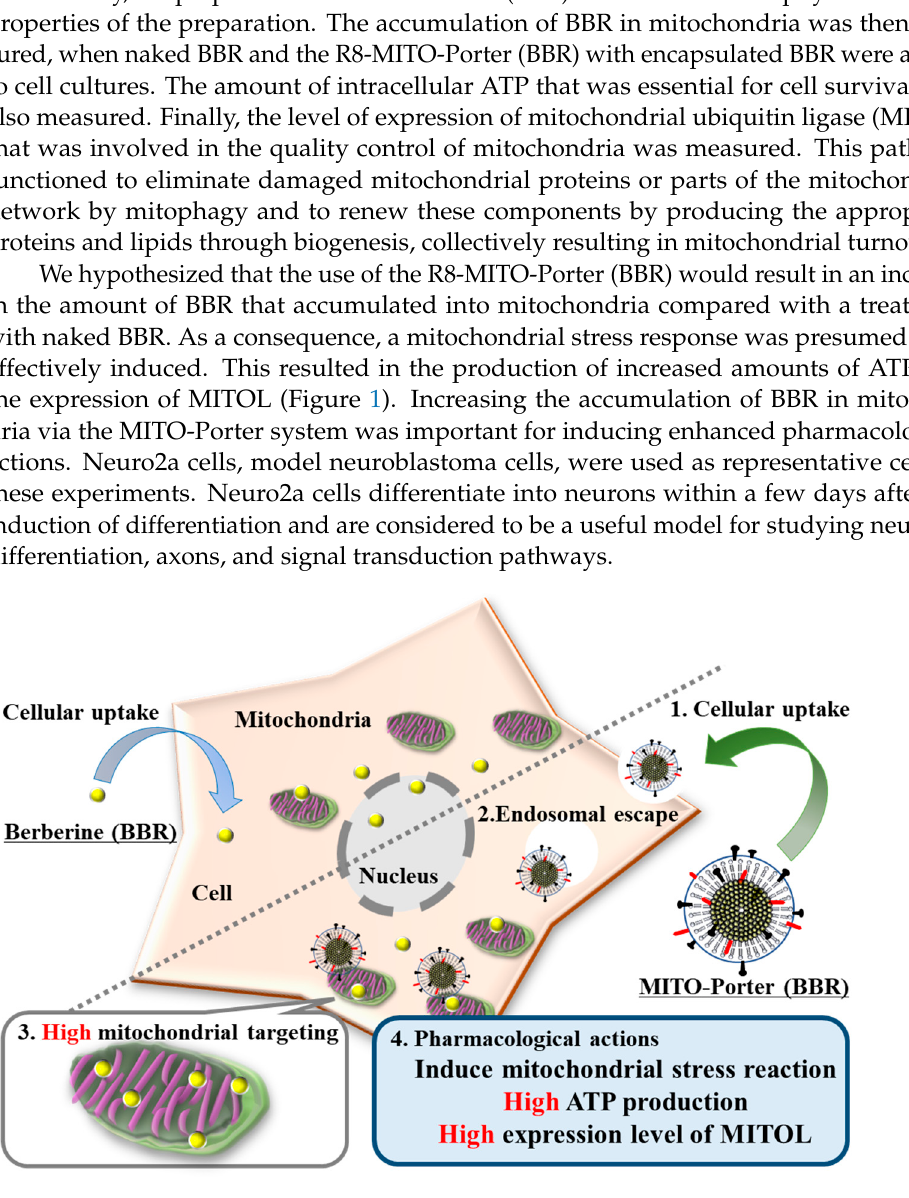
Figure 1. Schematic diagram showing the mitochondrial delivery of BBR using the MITO-Porter system. The use of the R8-MITO-Porter (BBR) resulted in an increased accumulation of BBR in mitochondria. This acted on the mitochondrial respiratory chain complex and induced a mito- chondrial stress response. As a consequence, intracellular ATP production and MITOL expression were